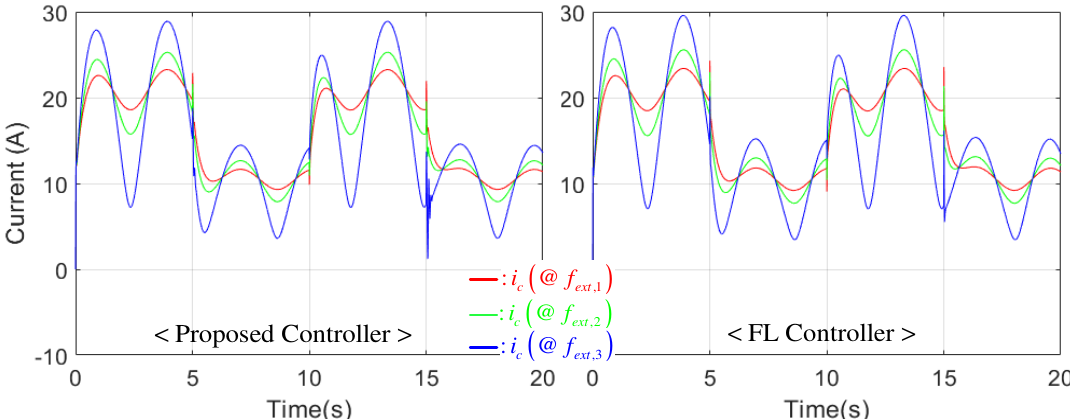
Figure 4. Current behavior comparison results under three types of external disturbances of f ext ,1 ( t ) , f ext ,2 ( t ) , and f ext ,3 ( t ) .